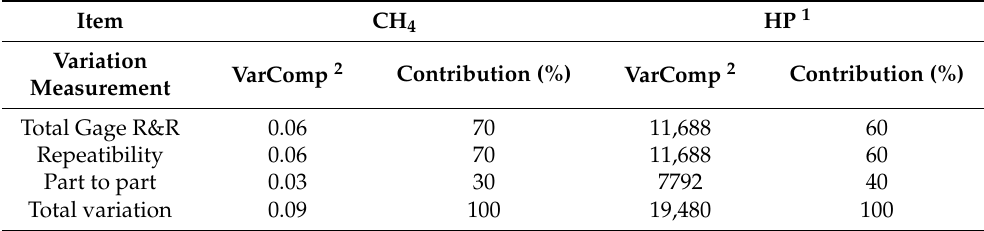
Table 2. Repeatability study of the respiration system.